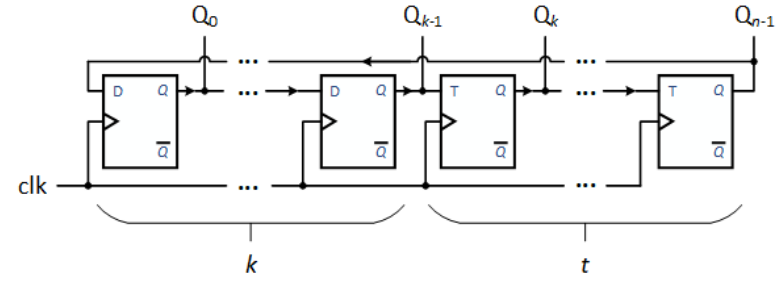
Figure 7. General structure of an n -bit DT-LFSR register.